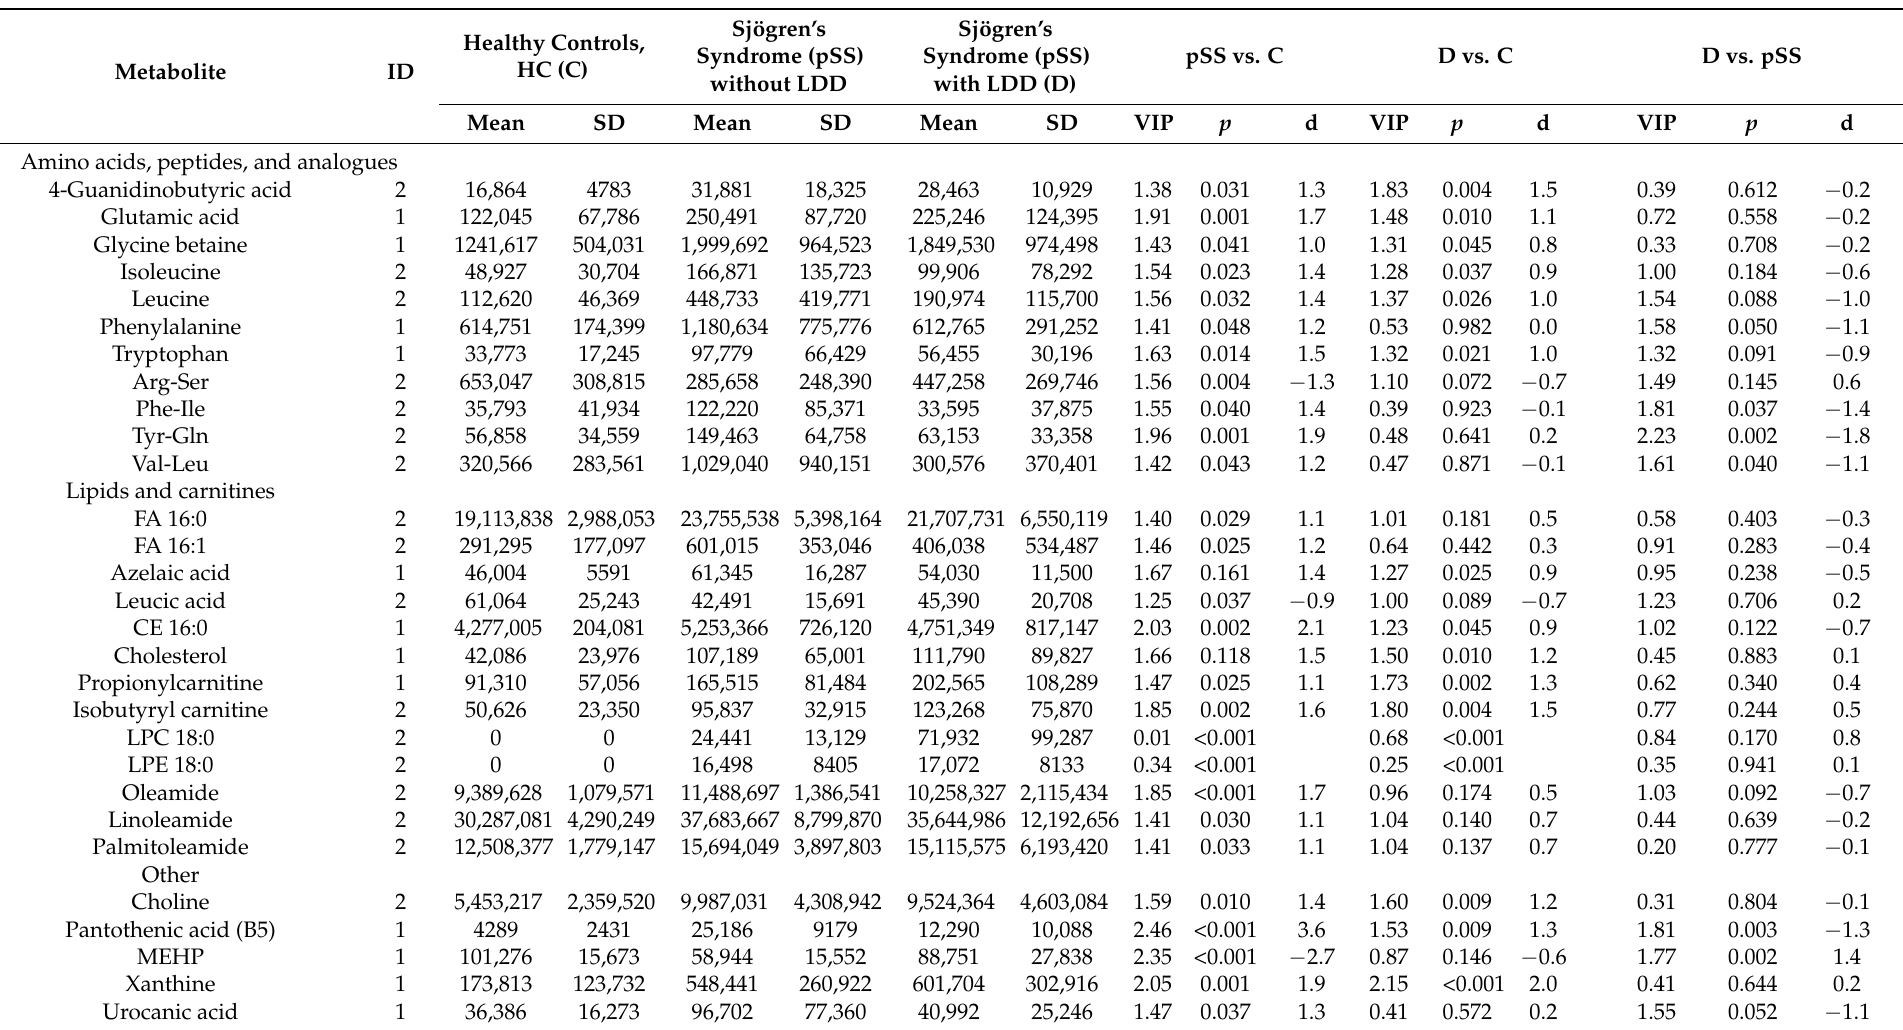
Table 1. Identified salivary metabolites associated with Sjögren’s